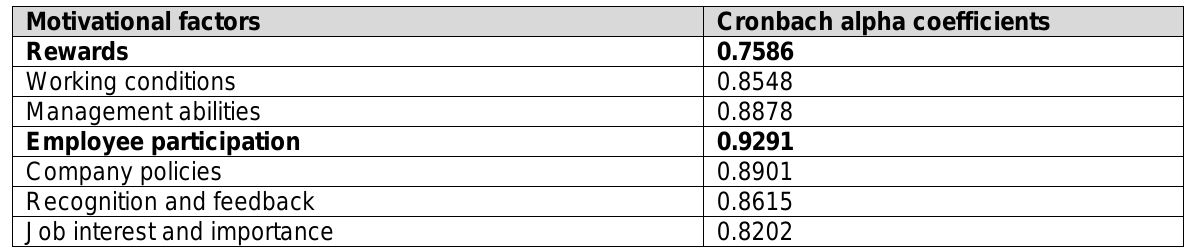
Table 1: Cronbach alpha correlation coefficients for motivational